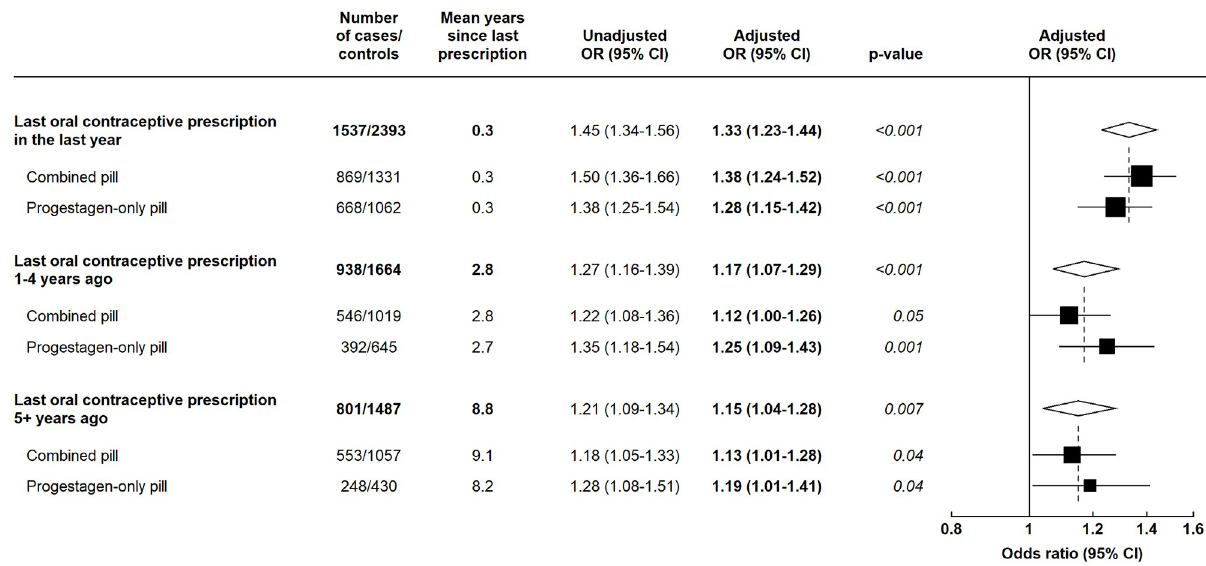
Fig 2. ORs and 95% CIs for breast cancer in women aged < 50 years whose last hormonal contraceptive prescription was an oral contraceptive versus women with no prescriptions for hormonal contraceptives, by time since last prescription and oral contraceptive type. Data from the CPRD. Adjusted ORs are adjusted for time since last birth, number of recorded births, BMI, and alcohol intake. P values are based on the relevant Wald tests. BMI, body mass index; CI, confidence interval; CPRD, Clinical Practice Research Datalink; OR, odds ratio.